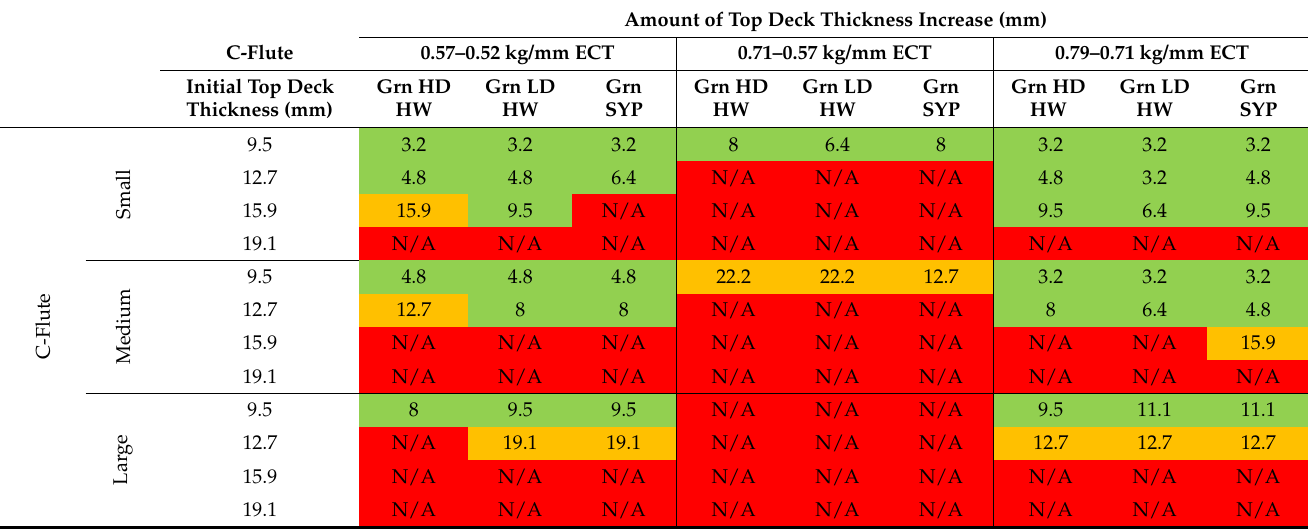
Table 4. The amount of top deck board thickness required to optimize unit loads consisting of C-flute boxes.